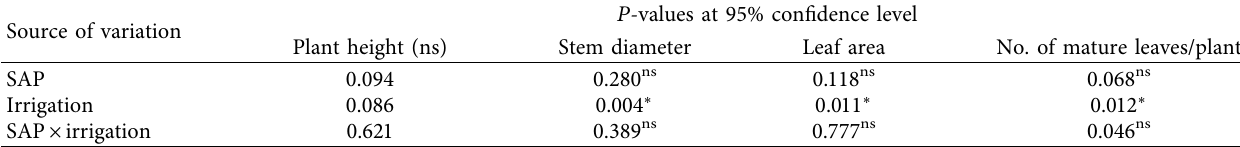
Table 5: ANOVA for dependent variables and their interaction with African nightshade plant at 95% confidence level. Source of